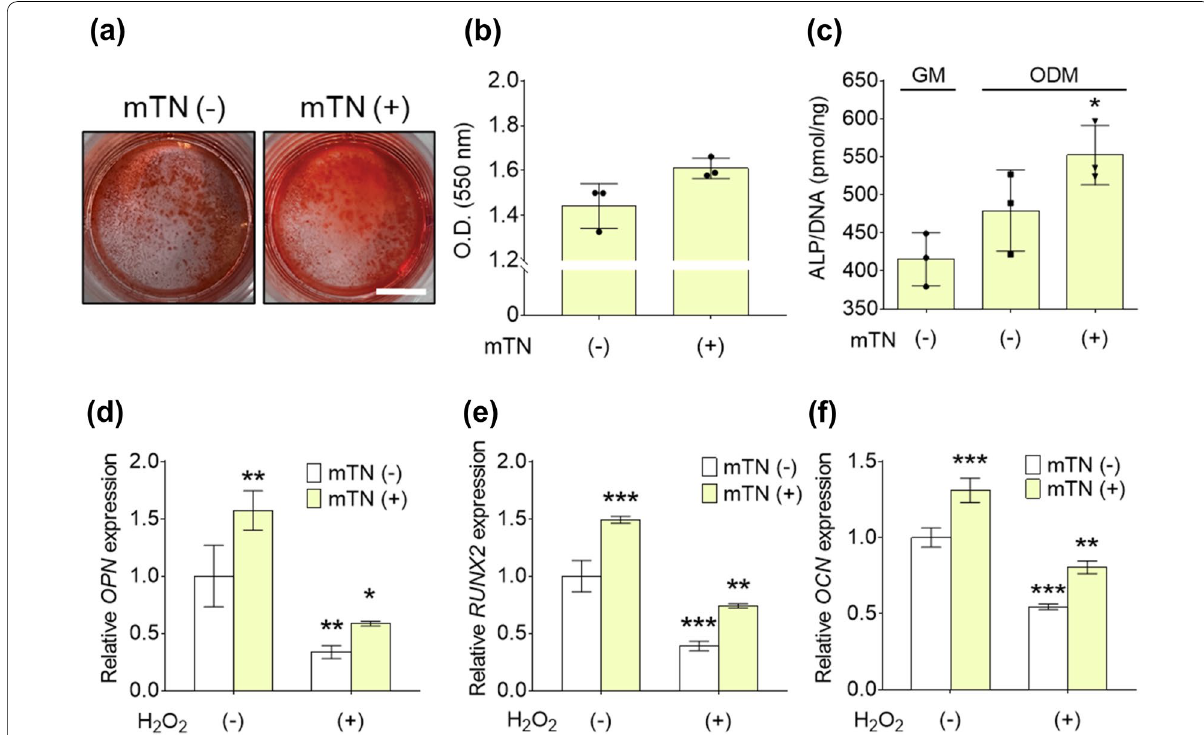
Fig. 6 a Alizarin red S staining images of hADSCs cultured with or without mTNs for 14 days (scale bar ALP activity of hADSCs cultured with GM and ODM with or without mTNs for 7 days. *Significantly different compared to GM ( p < 0.05). Relative mRNA expression of the osteogenic markers ( d ) OPN , ( e ) RUNX2 , and ( f ) OCN in hADSCs cultured in ODM with or without H 2 O 2 and mTNs for 14 days. , , significantly different compared to H 2 O 2 ( ∗ ∗ ∗ ∗ ∗ ∗